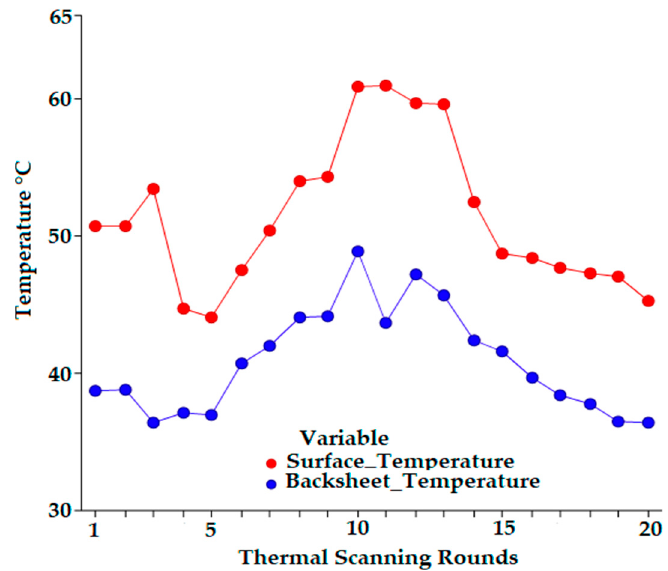
Figure 5. Thermal behavior of the developed solar module representing the performance of the surface and backsheets.